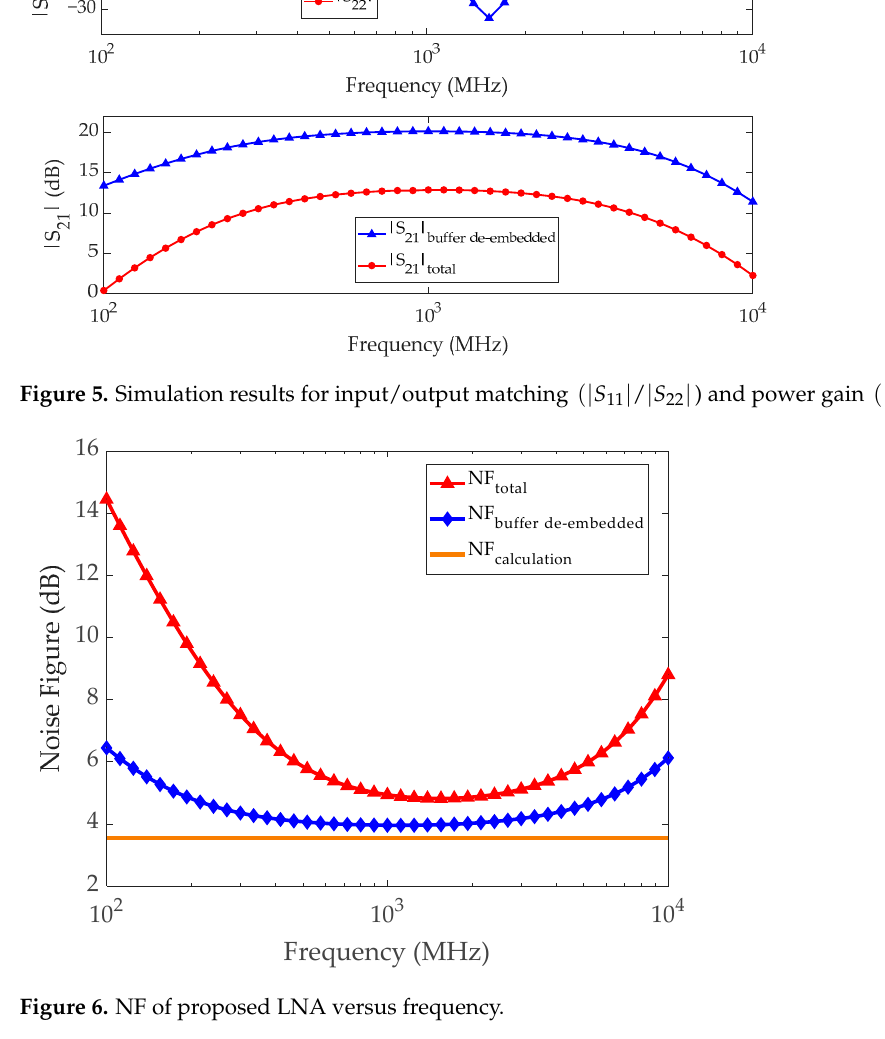
Figure 6. NF of proposed LNA versus frequency.